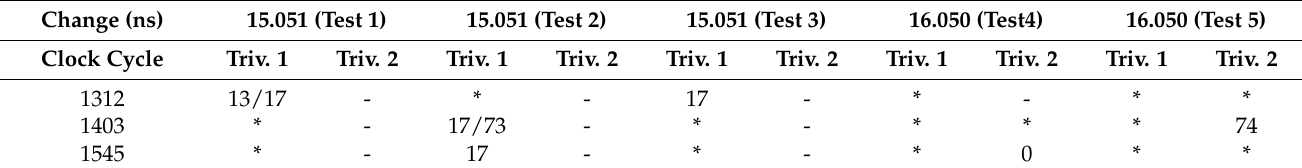
Table 10. Position of the faults injected into the standard Trivium cipher when the control signals are changed. Change